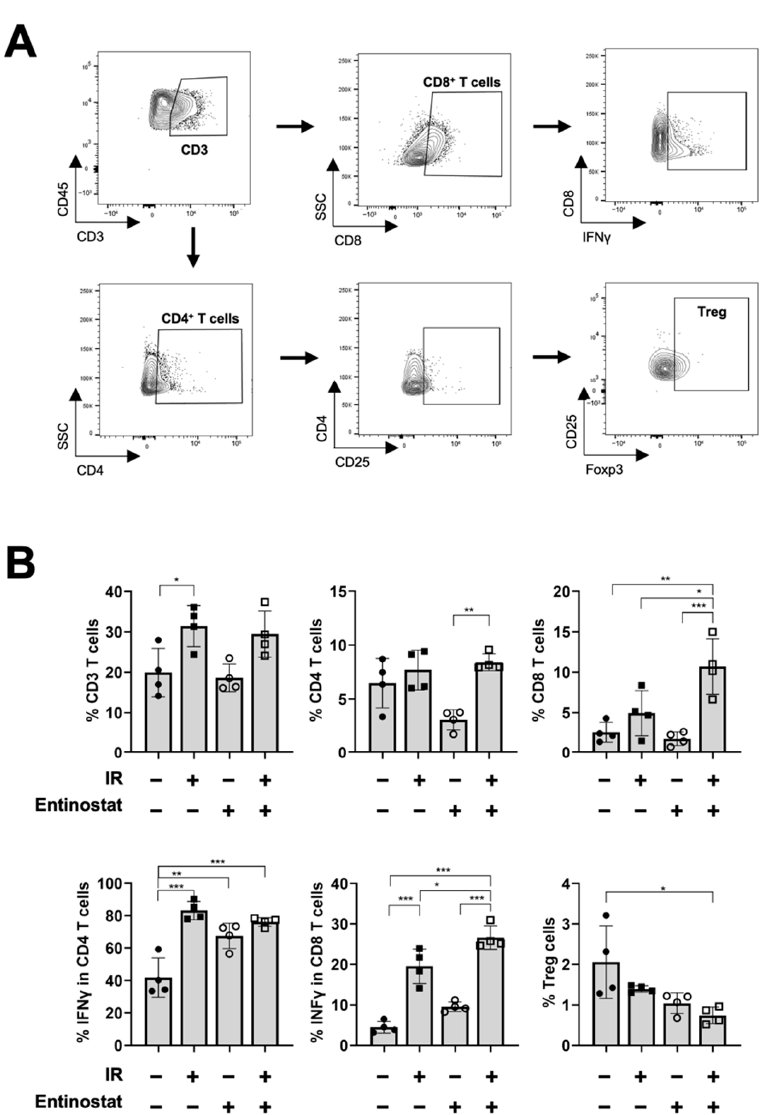
Figure 3. Entinostat increases radiation-induced CD8 + T cell infiltration in tumors. ( A ) Gating strategy for the evaluation of the T cell population using flow cytometry. Representative density plots are shown. ( B ) Flow cytometric analysis of T cell populations. Entinostat further enhanced radiation-increased infiltration of IFN- γ -producing CD8 + T cells in tumors. The combination of entinostat and IR decreased Treg cells in tumors. Data are mean ± S.D. ( n ≥ 4). * p < 0.05; ** p < 0.01; *** p < 0.001.